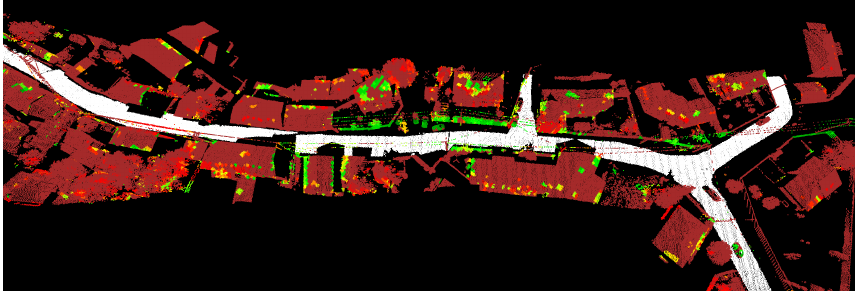
Figure 6. Vertical dispersion in the most detailed scale, KNN =